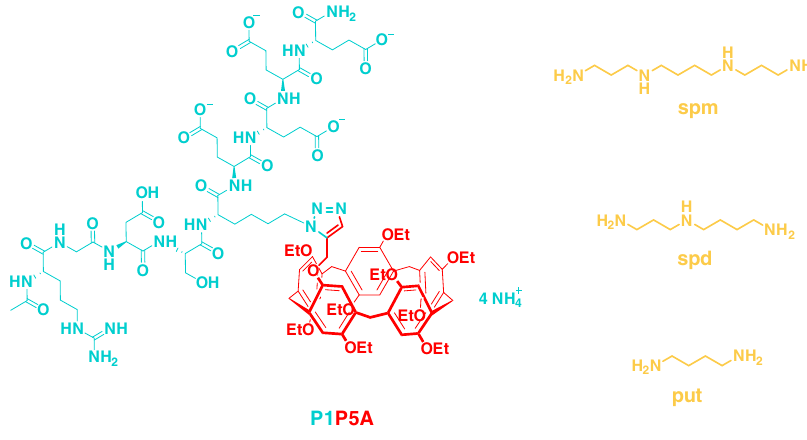
Fig. 1 Chemical structures of P1P5A and